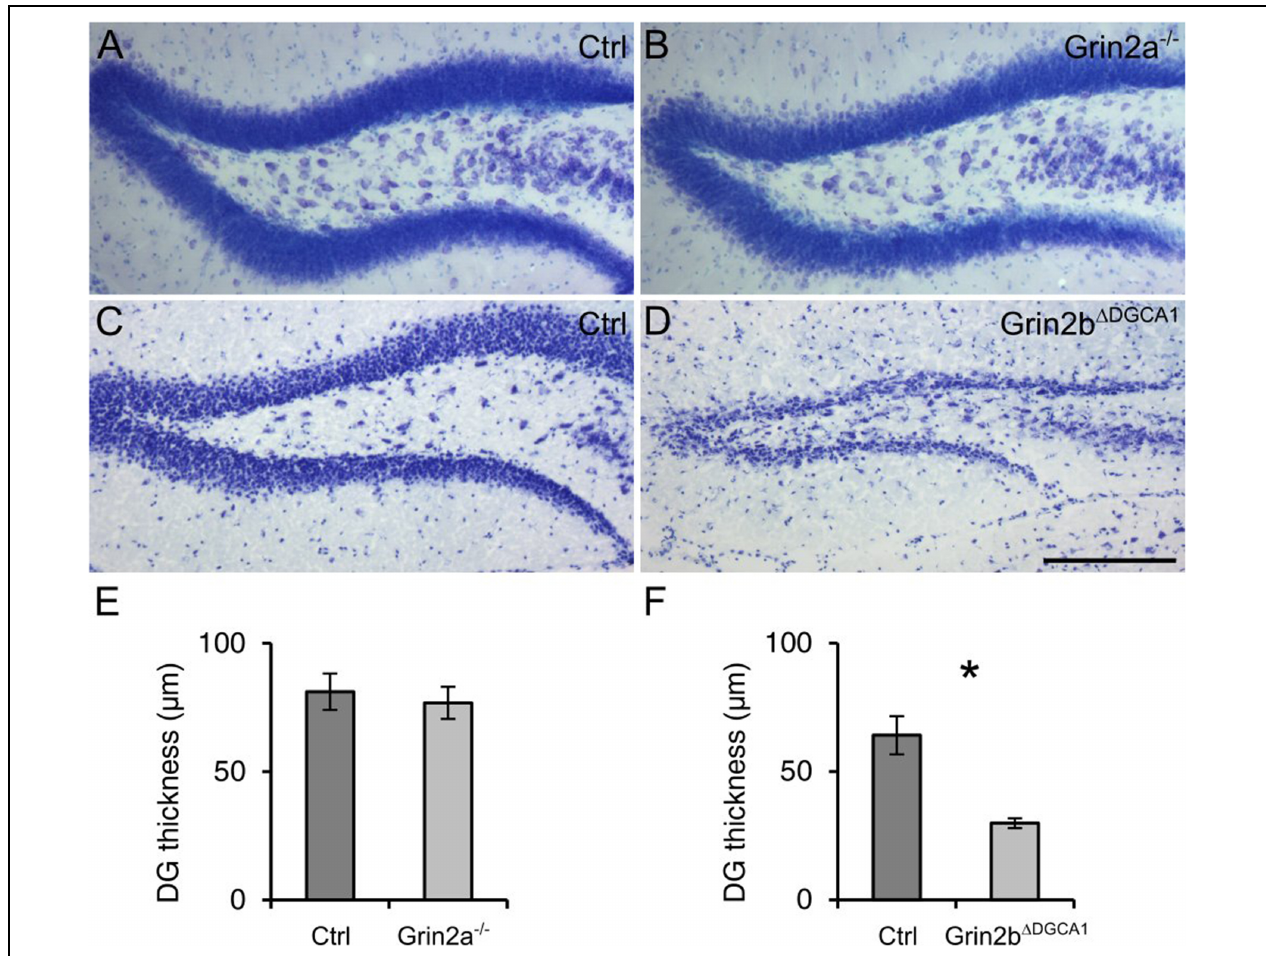
FIGURE 4 | Absence of GluN2B-, but not GluN2A-containing NMDARs causes age-associated neurodegeneration of granule cells in the dorsal DG. (A) Nissl staining of the DG from an 18 months old control mouse. (B) Nissl staining of the DG from an 18 months old Grin2a − / − mouse. (C) Nissl staining of the DG from an 18 months old control mouse. (D) Nissl staining of the DG from an 18 months old control mouse ( Grin2b (cid:2) DGCA 1 ). (E) Quantitative evaluation of the granule cell layer thickness in the DG of control and Grin2a − / − mice (Student’s t -test, ns). (F) Quantitative evaluation of the granule cell layer thickness in the DG of control and Grin2b (cid:2) DGCA 1 mice (Welch’s t -test, ∗ p < 0.05). Scale bar in (D) , 200 μ m. Four and three mice for control and Grin2a − / − , and three and three mice for control and Grin2b (cid:2) DGCA 1 were used,